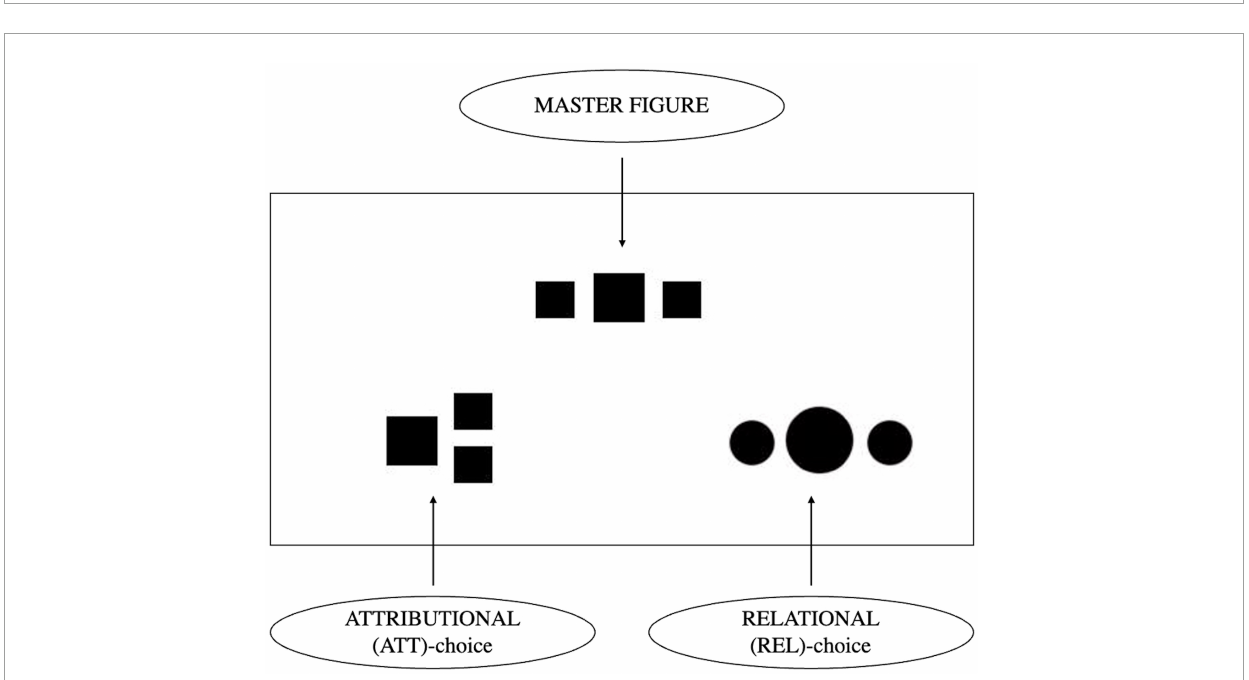
FIGURE2 Example of a triad of one item of the Geometrical Categorization Task consisting of a master figure and two target figures. The ATT-target (left) consists of the same components as the master figure but in a different configuration and is thought to probe for primary process mentation; the REL-target (right) is made up of different components, but these are arranged in the same total configuration and is thought to probe for secondary process